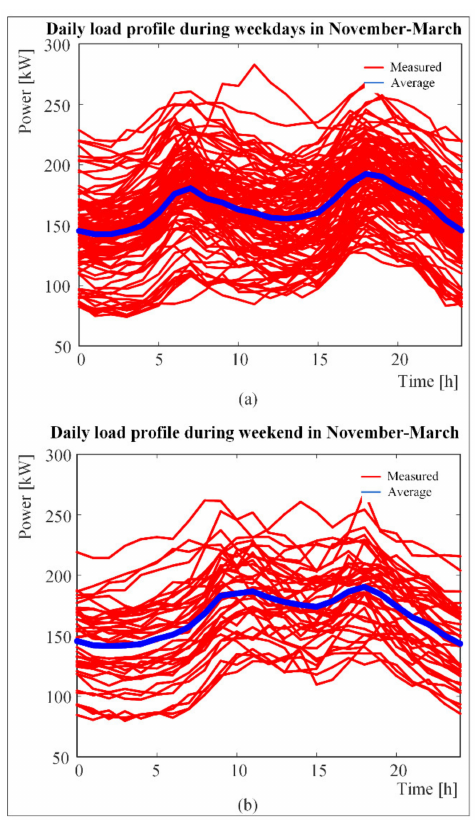
Figure 3. Power consumption from 1 November 2018 to 31 March 2019 ( a ) during weekdays and ( b ) during